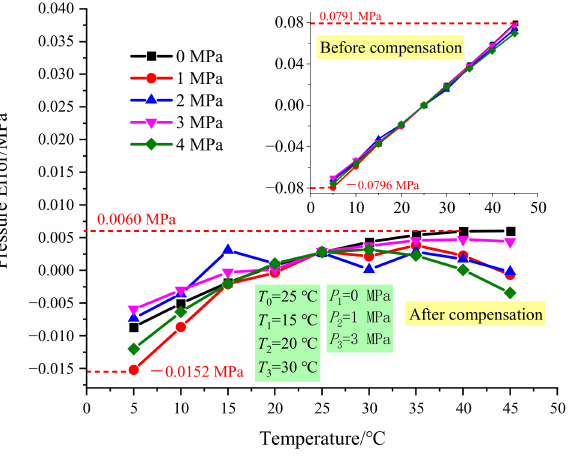
Figure 6. Errors when T 0 = 25 ◦ C.